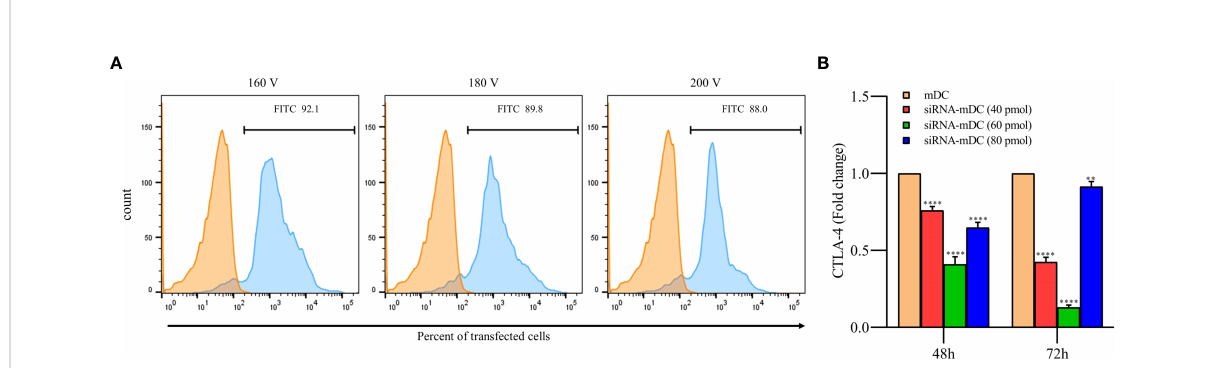
FIGURE 1 siRNA transfection outstandingly silenced CTLA-4 gene in mDCs. (A) Percentages of transfected mDCs obtained for the different pulse voltages. More than 92% of the mDCs were transfected with FITC-labeled control siRNA at 160 V. The viability of all transfected and un-transfected DCs, determined by the Trypan blue exclusion test, was above 90 percent. (B) CTLA-4 mRNA expression was suppressed in mDCs after 72 hours of